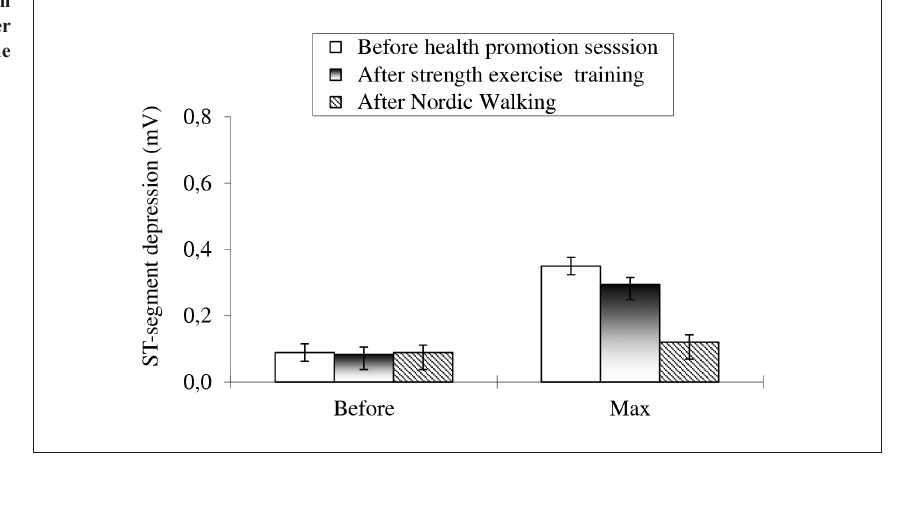
Figure 3. Diastolic ABP